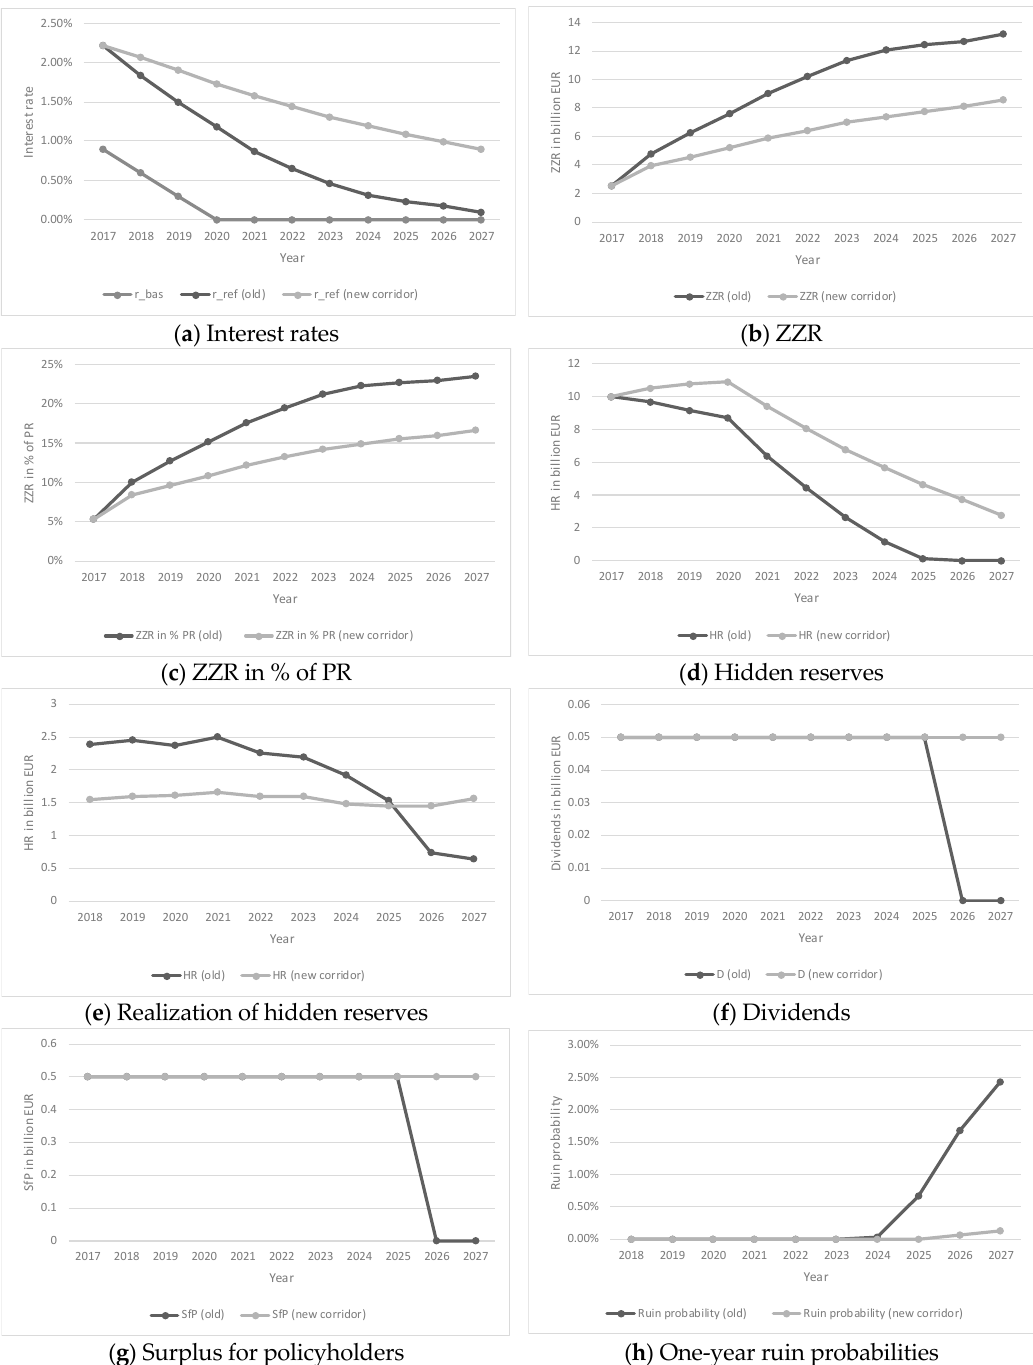
Figure 2. Simulation results in interest rate scenario 2.